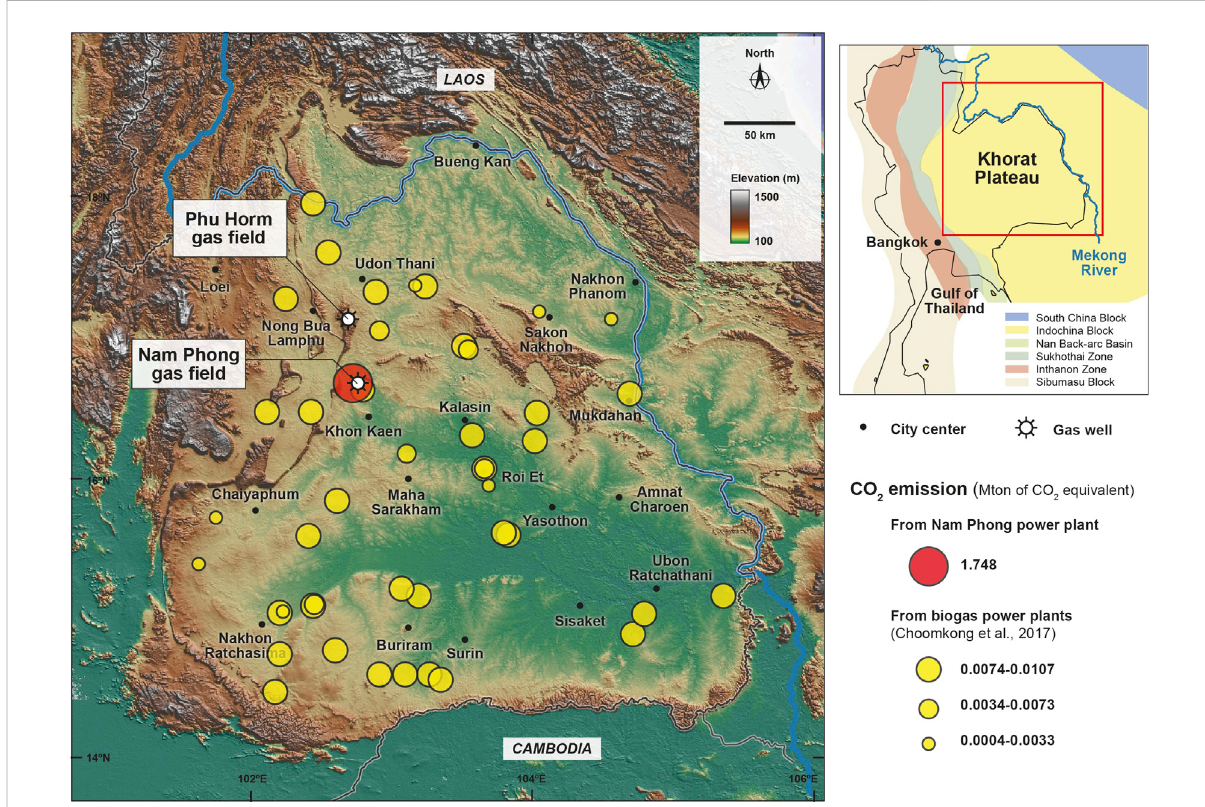
FIGURE 2 Location map of the Khorat Plateau, northeast Thailand, showing the major CO 2 emission point sources for geological storage (CO 2 emission data sourced from Choomkong et al.,